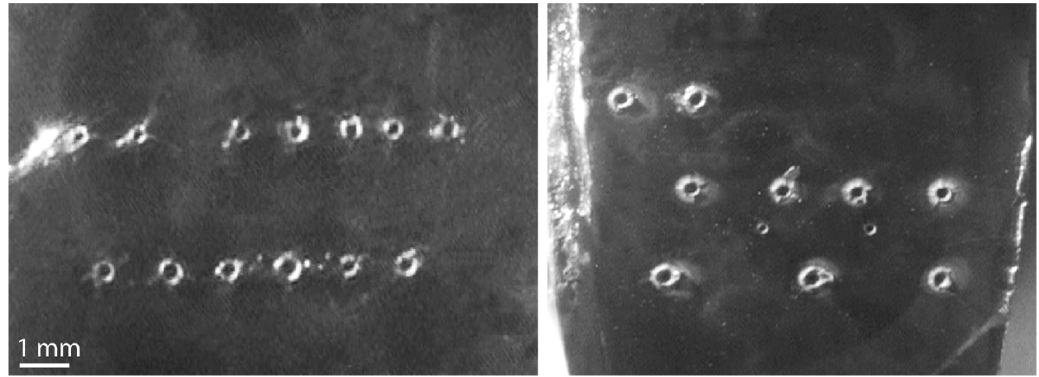
Figure 5. Surface of studied GaSe samples no. 1 ( left ) and no. 2 ( right ) upon laser radiation exposure.